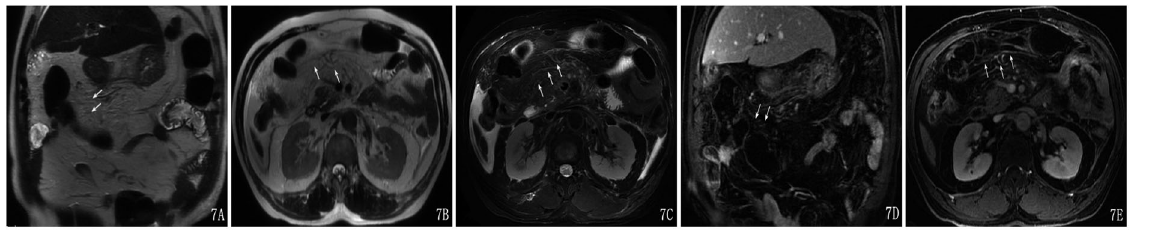
Figure 7. A 46-year-old male with mild AP and TMI was Grade I. Transverse-mesocolon-vessel involvement could be seen on a coronal SSFSE T2-weighted image (A), on an axial SSFSE T2-weighted image (B) and on an axial SSFSE T2-weighted image with fat suppression (C). The transverse mesocolon vessels showed the vessel-lumen expansion and dilated and tortuous lateral-branch small vessels on enhancement of the coronal image (D) and axial image